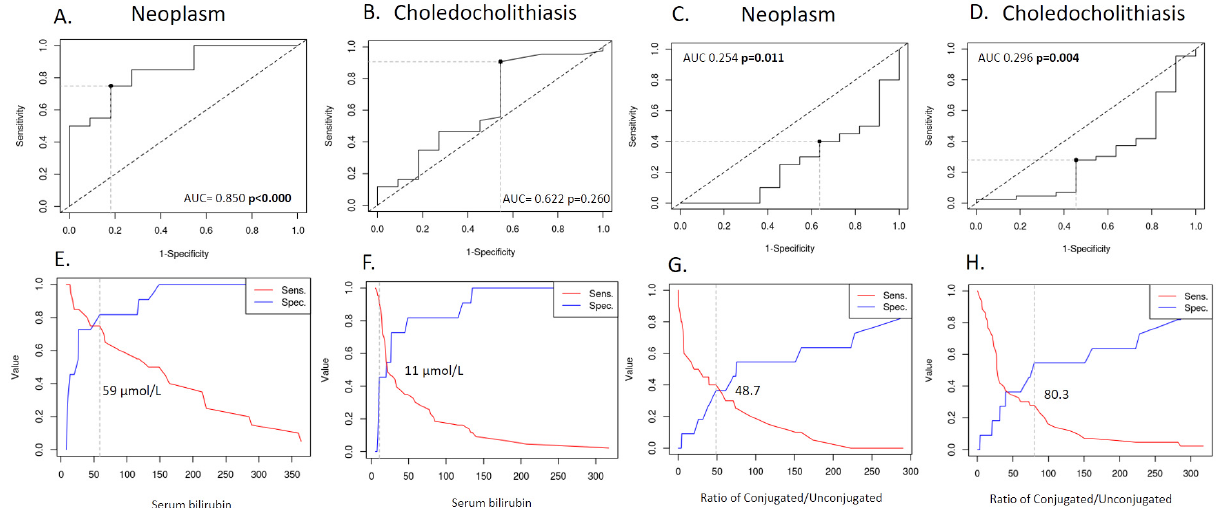
Figure 7. ( A – D ) ROC curves comparing neoplasms (both cholangiocarcinoma and pancreatic, ( A , C )) and choledocholithiasis cases ( B , D ) to the benign stricture cases using two indicators: serum bilirubin and the ratio of conjugated/unconjugated BSs. In three cases (p-value marked in bold), the ROC curve presented a statistically significant indicator. The corresponding cut-off values ( E – H ) are given under each ROC curve.